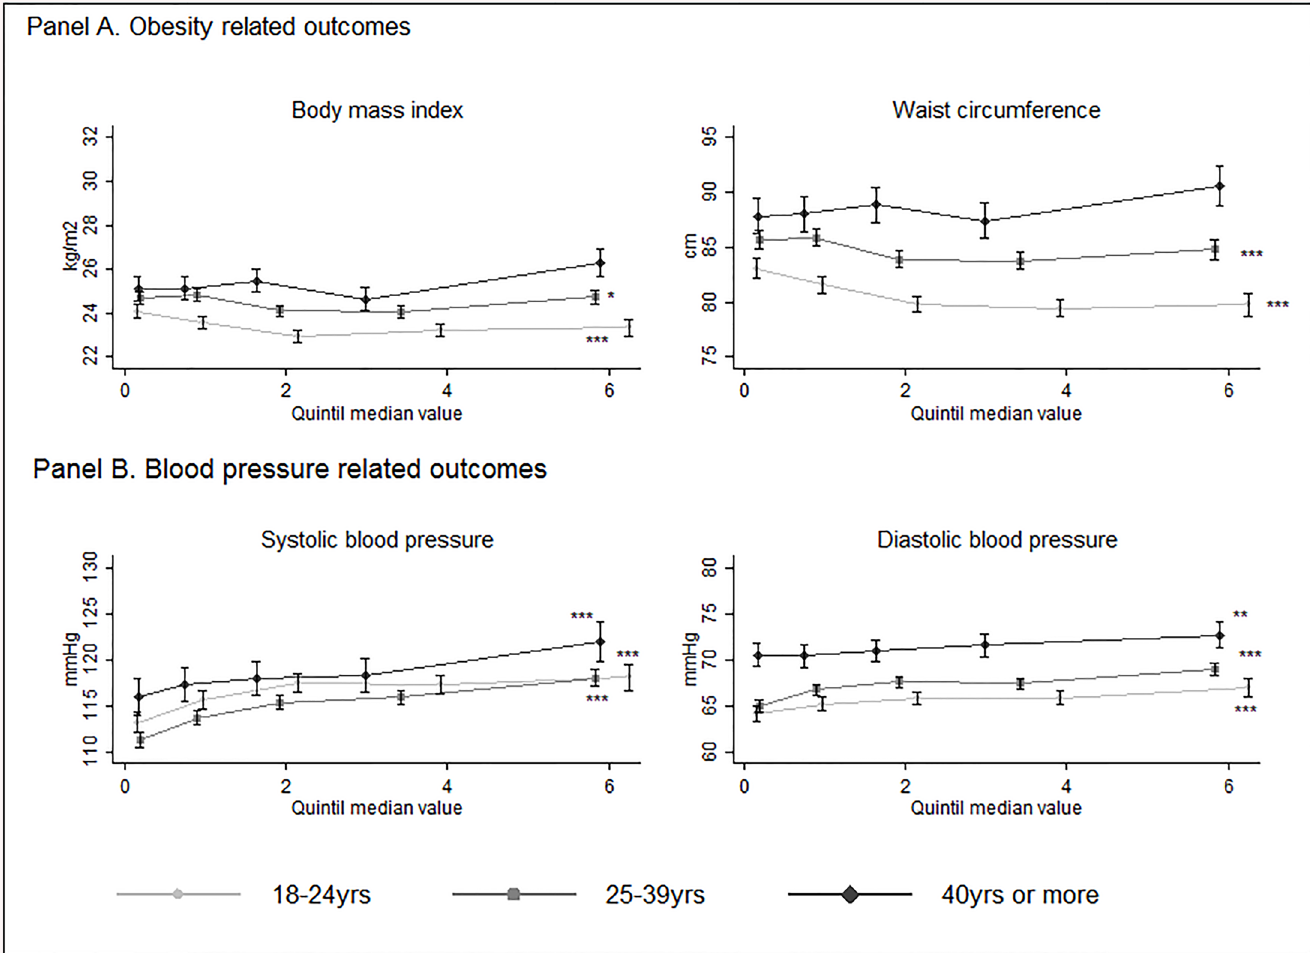
Fig 1. Quantile Regression Estimates for blood pressure and anthropometric outcomes stratified by age at admission to the prison. BMI and WC models adjusted by current age, facility and an interaction term between length and facility. BP models adjusted by age, facility, BMI and an interaction term between length and facility. P for trend: * p < 0.05, ** p < 0.01, *** p < 0.001.